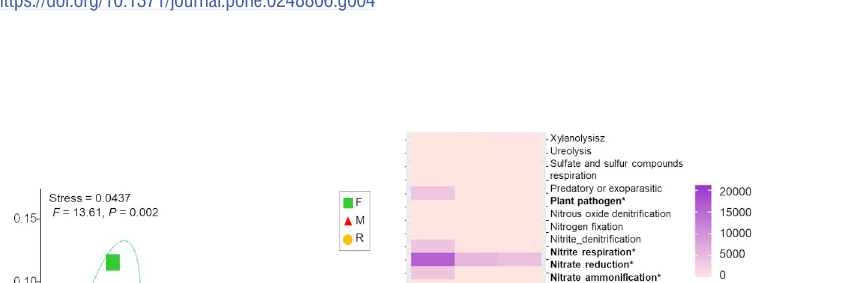
Fig 4. Taxonomic distribution of living bacteria. Distribution data, derived from forest (F), mine (M) and young mine-rehabilitation plot (R) samples, in terms of relative abundance (top left) and incidence (bottom left) data, at genus level (colored-boxes legend). The lines indicate the order (dotted) and phylum (solid) of bacteria detected.